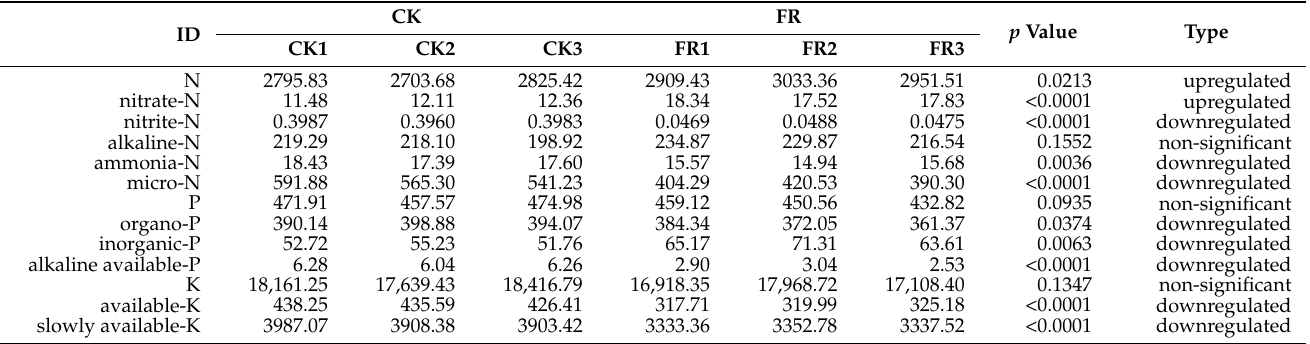
Table 1. Nutrient status (NPK) of the soils in FR compared with CK zones in a fairy ring ecosystem. The numbers mean